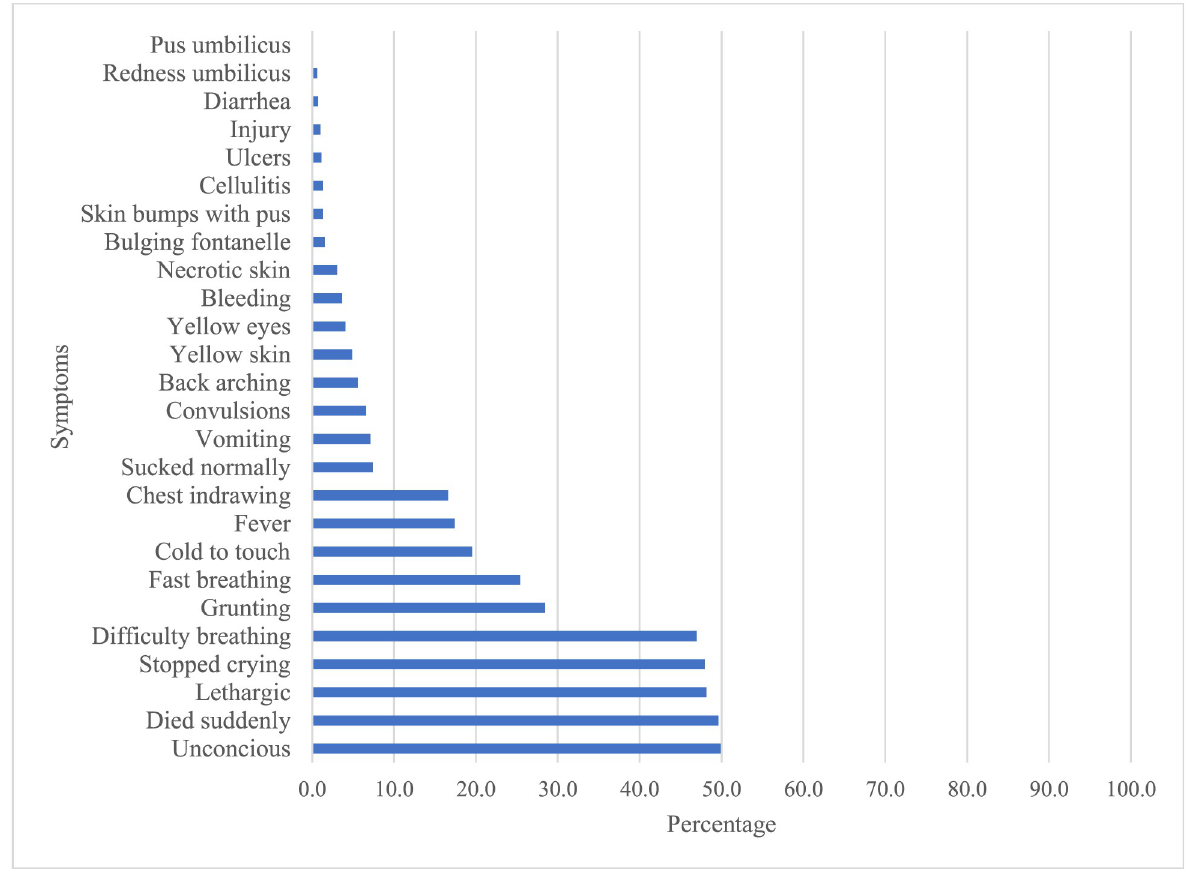
Fig 2. Symptoms reported in verbal autopsy among neonatal deaths (n =